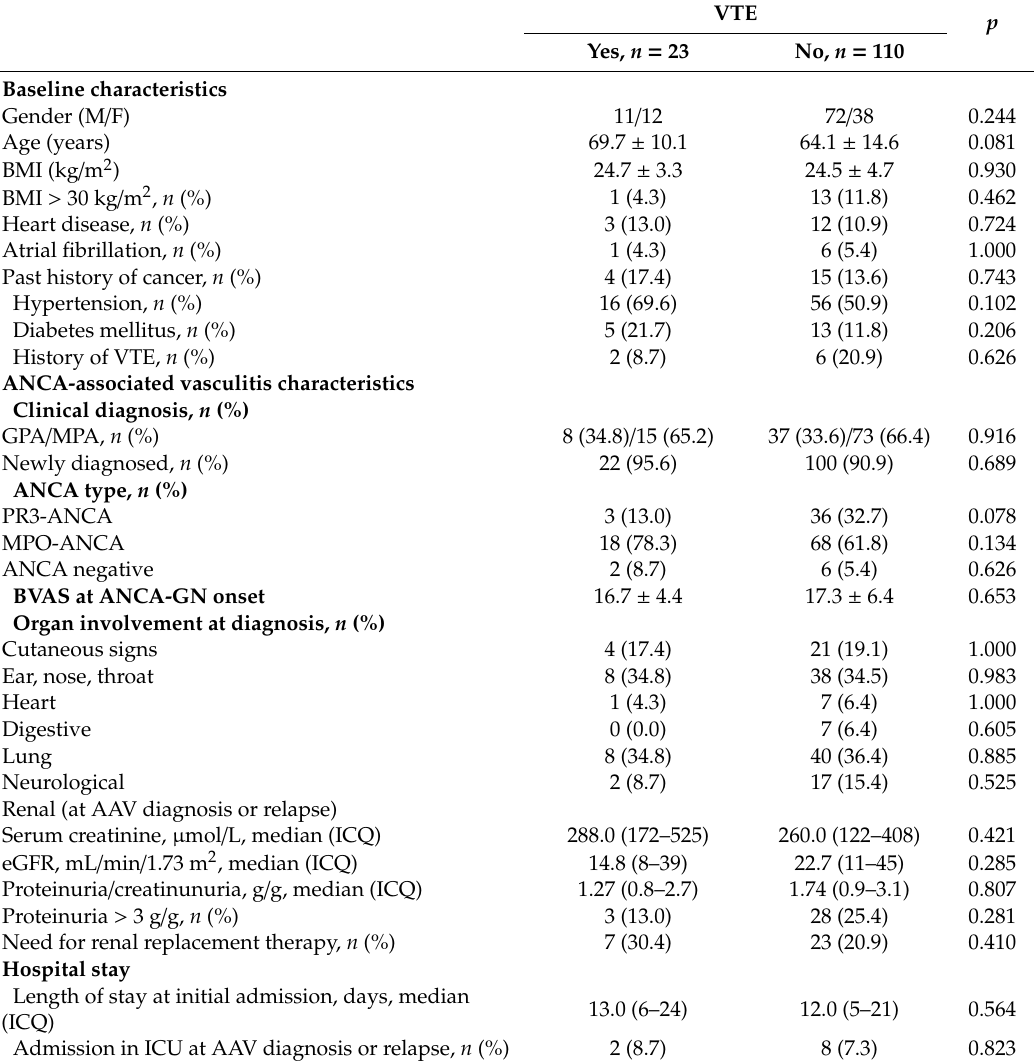
Table 3. Comparison of baseline characteristics of patients according to venous thromboembolic events